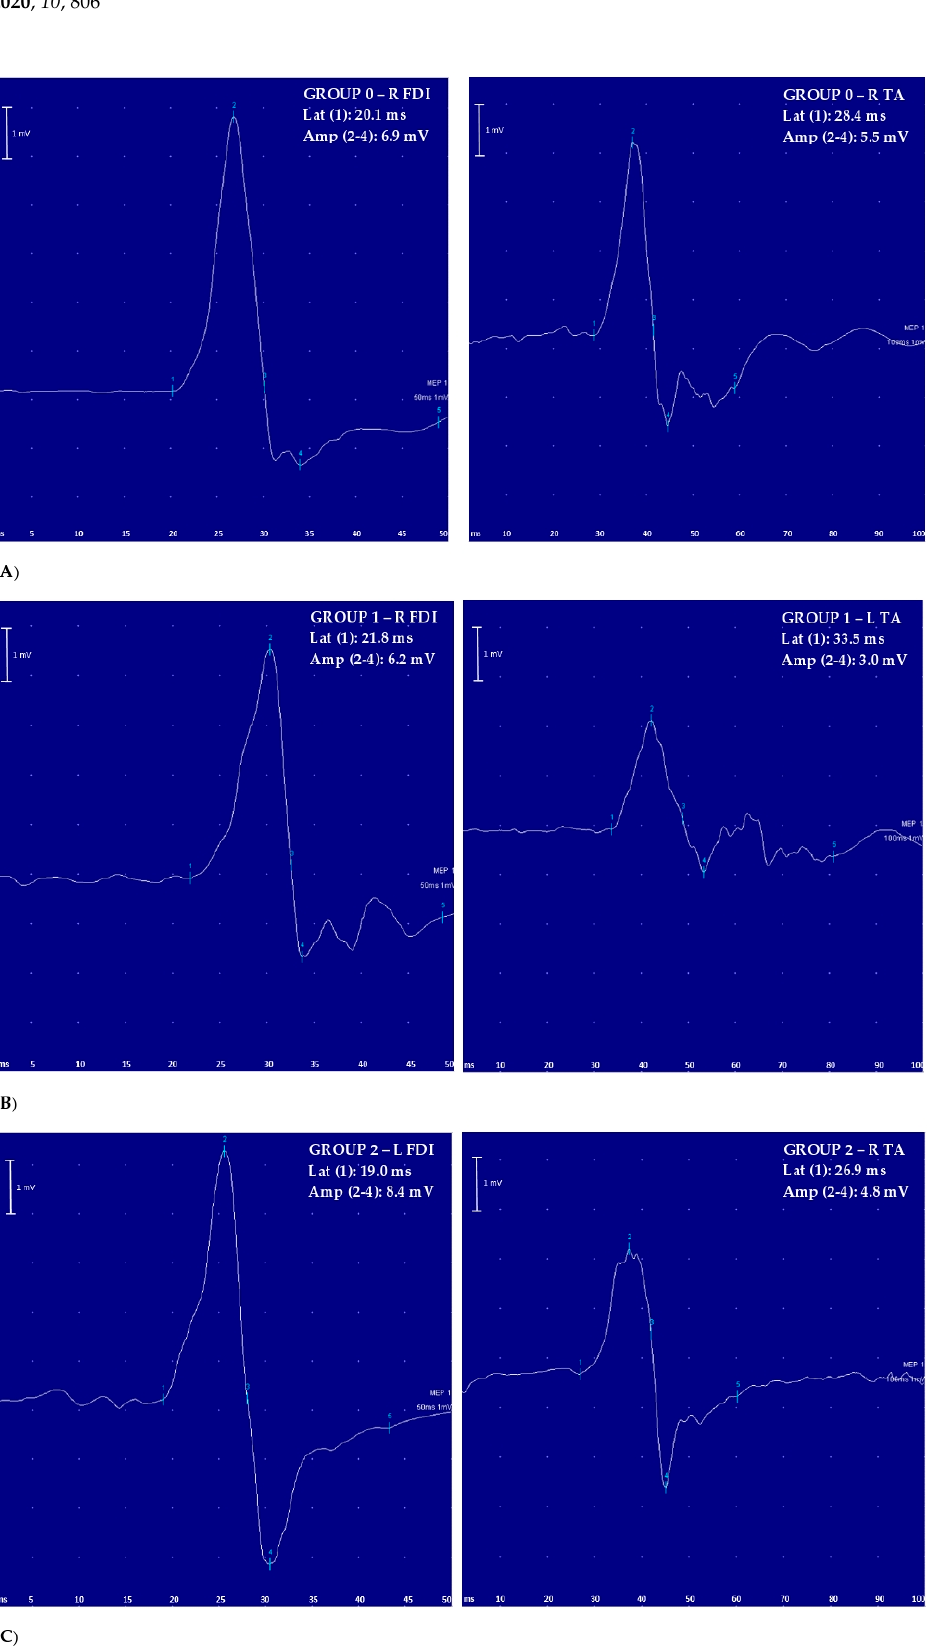
Figure 1. Examples of motor-evoked potential (MEP) recorded for each study group (left side: upper limb; right side: lower limb): ( A ) Group 0: healthy controls; ( B ) Group 1: patients with signs of